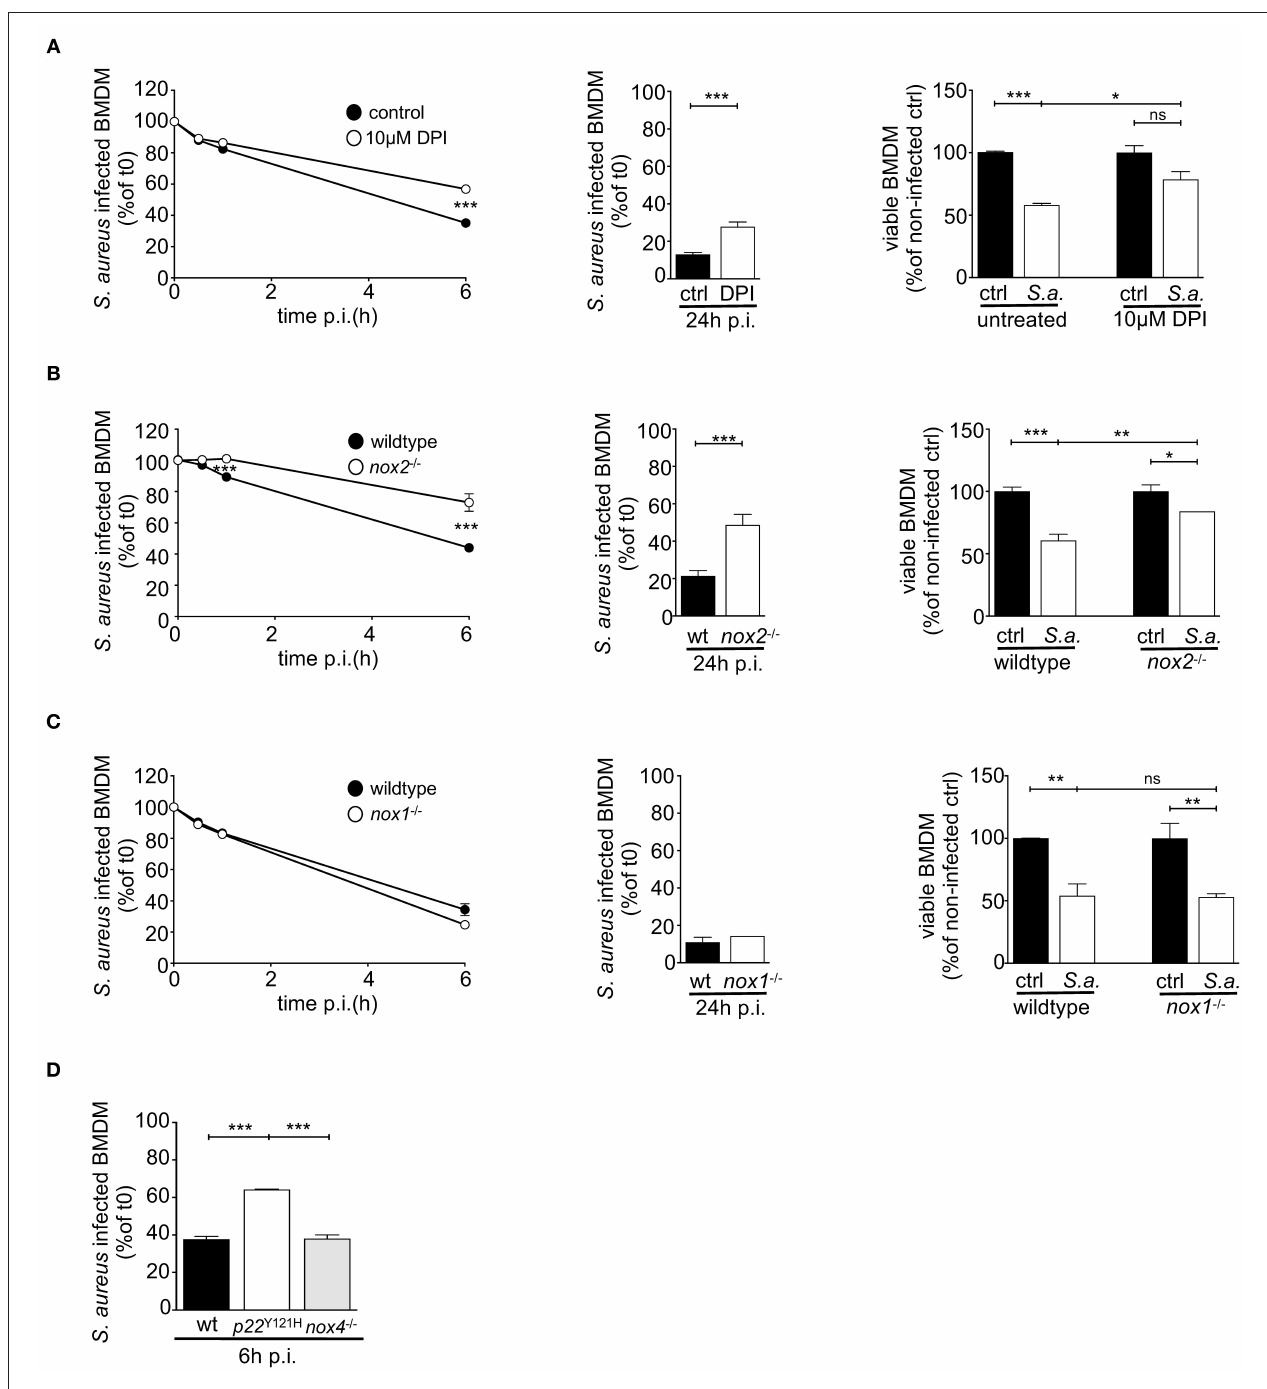
FIGURE 2 | S. aureus clearing and survival of infected BMDM depend on functional NOX2. BMDM were infected with GFP-expressing S. aureus MW2 (MOI15) opsonized with 5% NMS in suspension and assessed 24h p.i. by flow cytometry for clearing of S. aureus and for BMDM viability (right panel). (A) BMDM pre-treated with 10 µ M DPI (open circles) or left untreated (closed circles), (B) wildtype (closed circles) and nox2 − / − BMDM (open circles), (C) wildtype (closed circles) and nox1 − / − BMDM (open circles). Statistical significance was analyzed by unpaired two-sided Student’s t -test using GraphPad Prism 5.01 between indicated conditions (** = p < 0.01; *** = p < 0.001). The viabilities of BMDMs at 24h p.i. were assessed by trypan blue exclusion and depicted as bar charts ( A–C , right). Represented is the percentage of viable cells referring to corresponding non-infected cells for each genotype in mean and SD of triplicates. Statistical significance was analyzed by 1-way ANOVA with Bonferroni post-test between selected pairs as implemented in GraphPad Prism 5.01 between indicated conditions (* = p < 0.05; ** = p < 0.01; *** = p < 0.001). (D) Clearing kinetics of wildtype, p22phox Y121H and nox4 − / − at 6h post infection. Shown are means and SD of triplicates as percent of corresponding values at t0. Shown are representative experiments performed three times. NOX, NADPH Oxidas; ROS, reactive oxygen species; PMA, phorbol 12-myristate 13-acetate; DPI, diphenyleniodonium; MOI, multiplicity of infection; BMDMs, bone marrow derived macrophages; SD, standard deviation; TLR2, Toll-like receptor 2; NMS, normal mouse serum; p.i., post infection; CFU, colony forming unit; i.v., intravenous; s.c., subcutaneous.